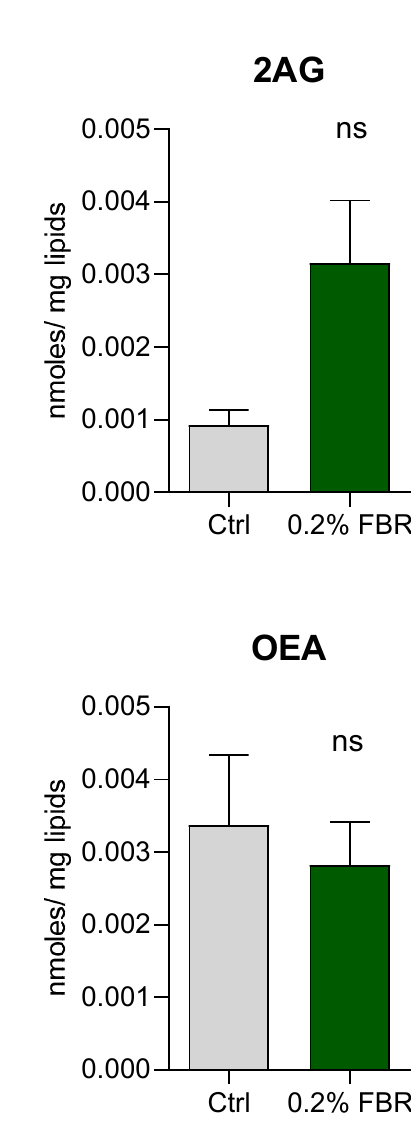
Figure 5. Visceral adipose tissue (VAT) levels of the endocannabinoids (eCB), arachidonoylethanolamide (AEA) and 2‑arachidonoylglycerol (2‑AG), and the eCB‑like molecules, palmitoylethanolamide (PEA) and oleoylethanolamide (OEA), in mice fed a control diet (Ctrl) or a 0.2% fenofibrate‑supplemented diet (0.2% FBR). Data are expressed as nmoles/mg of lipids and represent the mean ± SEM of n = 5. * p ≤ 0.05; ns = not significant.